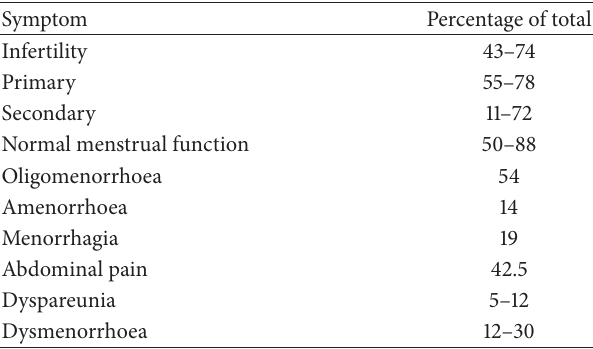
Table 1: Presenting symptoms of genital